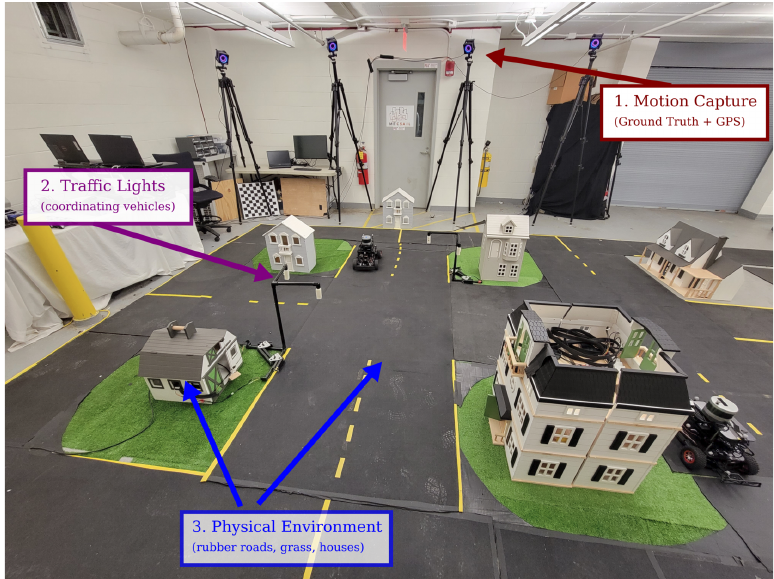
Figure 3. MiniCity Infrastructure. (1) External motion capture, (2) traffic lights, (3) physical roads and houses, and city maps allow multiple vehicles to drive around while testing a vehicle’s percep- tion